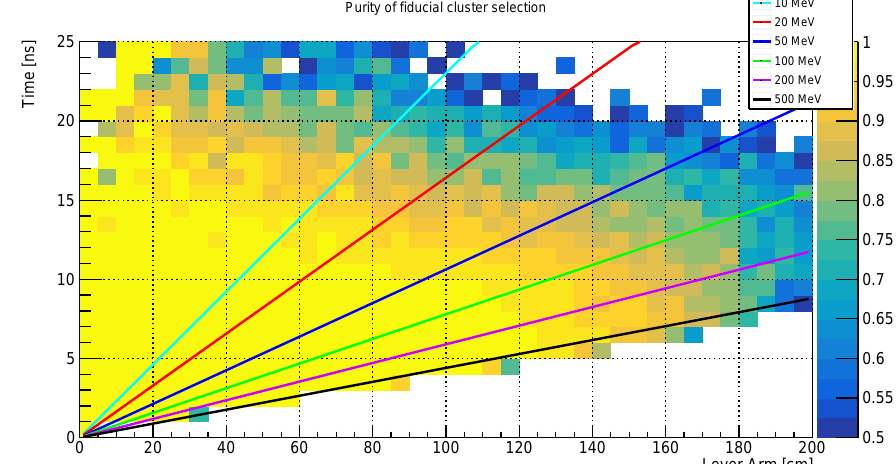
Figure 137. The purity for selecting in-fiducial neutron candidate clusters (mostly due to neutrons and photons) as a function of the time and distance from the vertex. The time and vertex can be used in the analysis to tune the purity. The efficiency for detecting the clusters is 60%, largely independent of time and space. The impurity in this plot is due to the out-of-fiducial neutron and gamma background. This plot was made with a ¯ ν µ -CC inclusive sample of